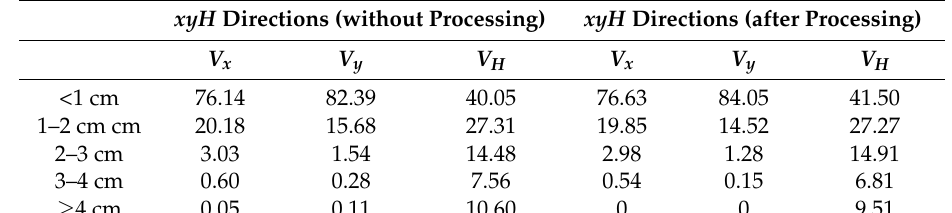
Table 6. Statistics of differences in position in relation to the coordinate time series of the monitoring point (%).